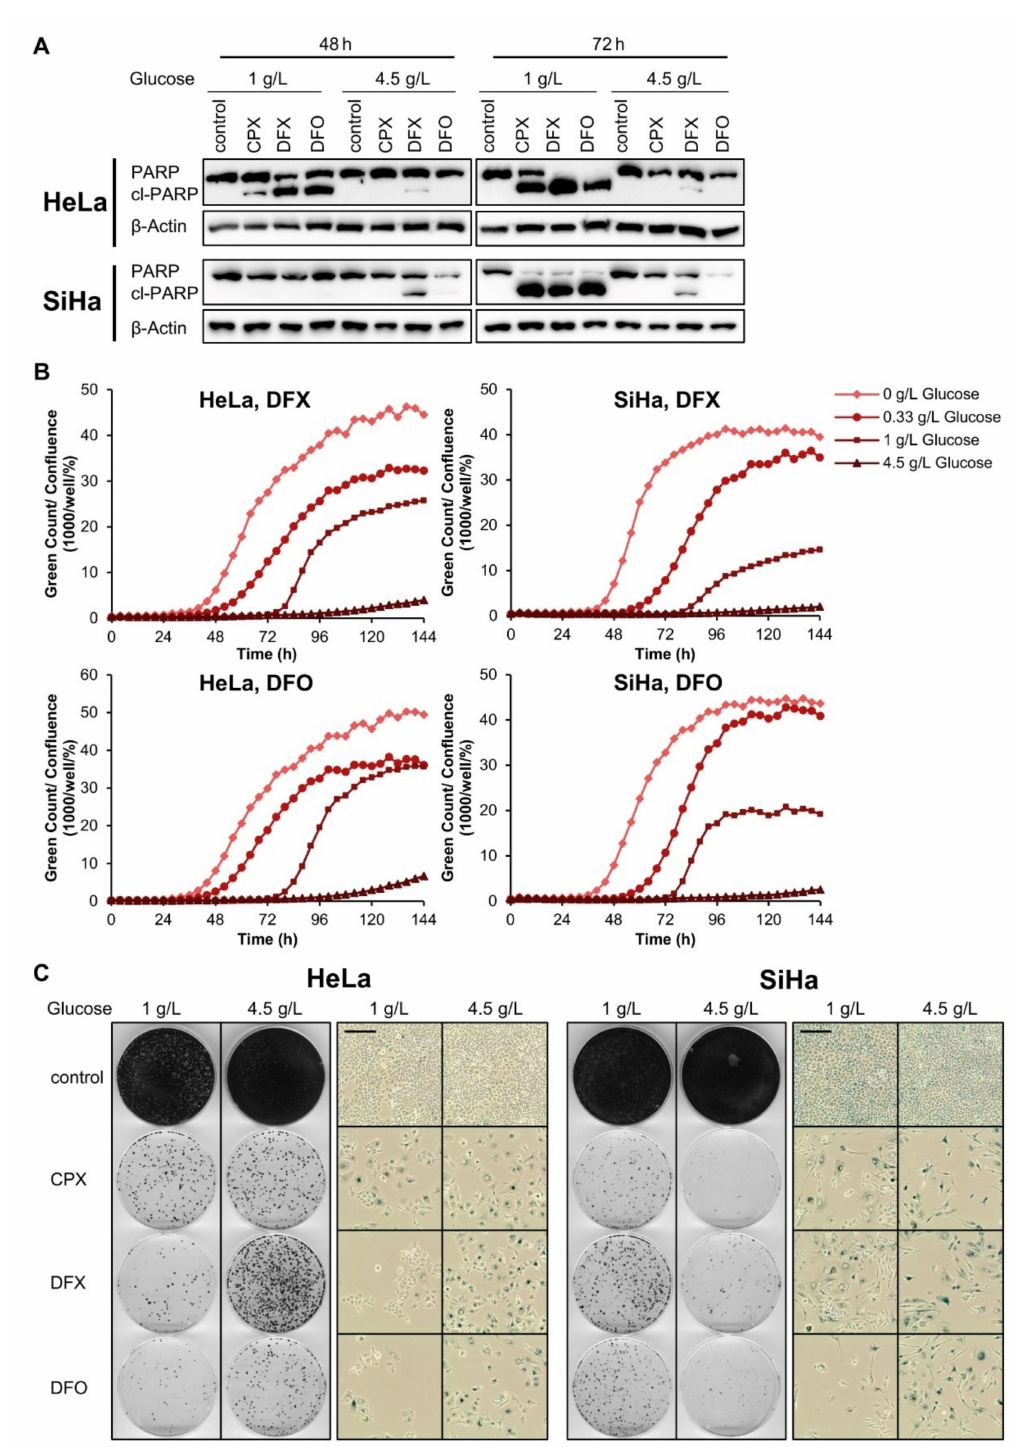
Figure 6. Iron chelators induce apoptosis in a glucose-dependent manner and act pro-senescent under increased glucose availability. ( A ) Immunoblot analyses of PARP and cl-PARP levels in HeLa or SiHa cells, treated with the indicated